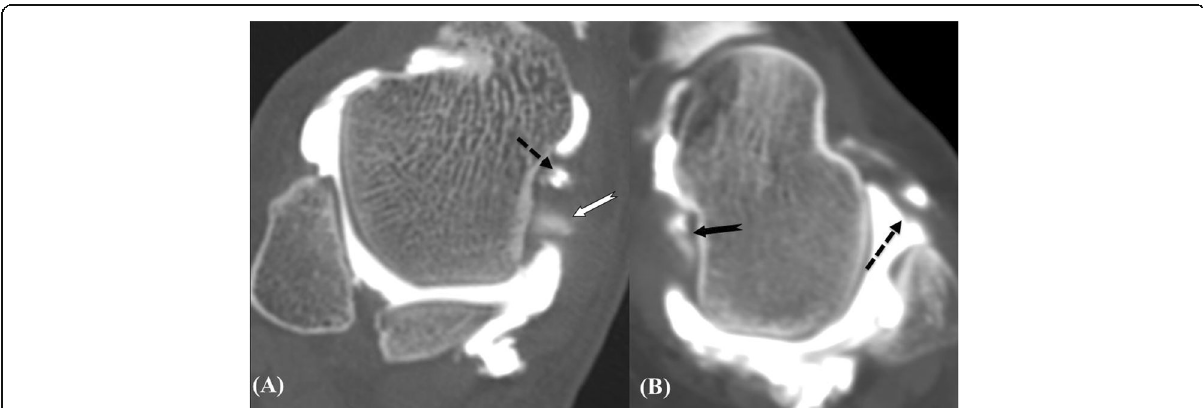
Fig. 7 Axial CTA images of two different patients had previous medial ankle sprain and currently pain. a Both band deep deltoid tear with contrast passage within the anterior (dashed black arrow) and posterior (white arrow) bands. b Isolated anterior band deep deltoid ligament tear with contrast passage within its fibers (notched arrow), also ATFL irregularity and bowing are present (dashed